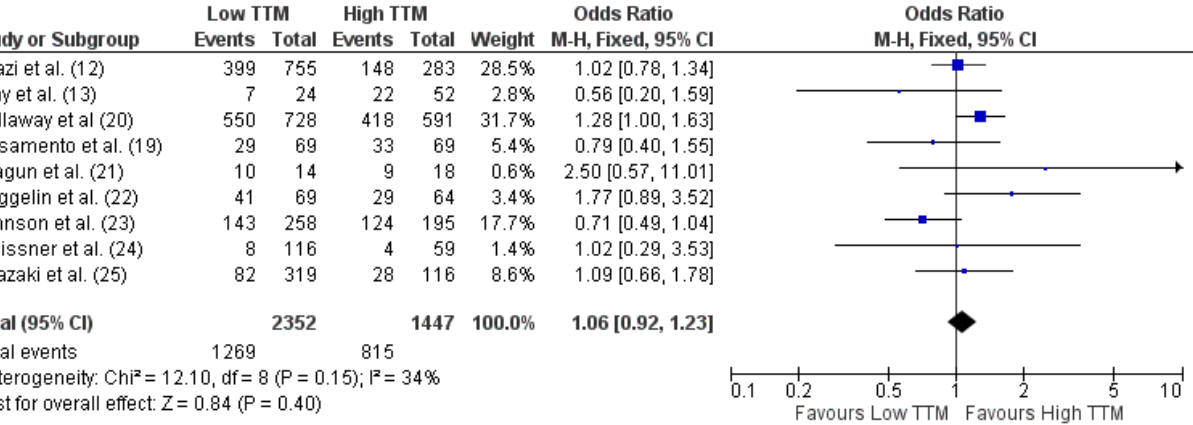
p = 0.87) than those treated at 36 ◦ C (Figure 3).